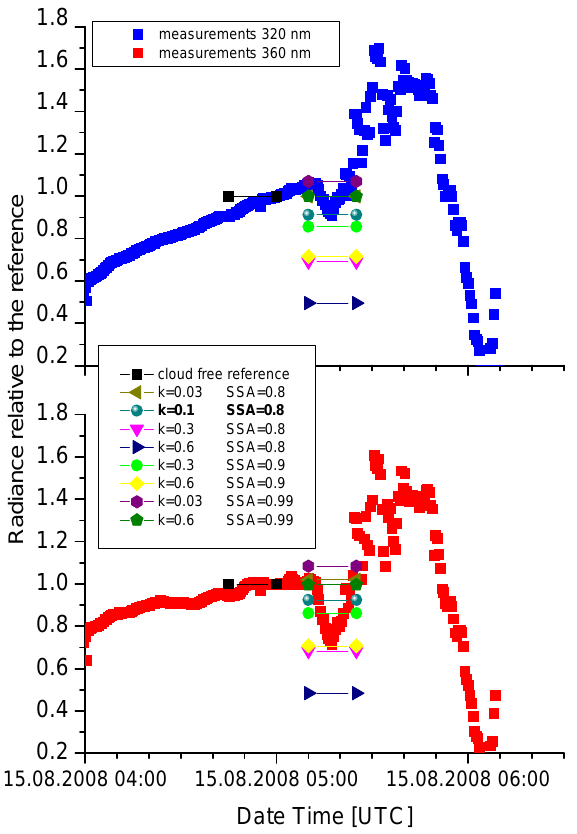
Fig. 14. Simulated and modelled intensity ratios for − 10 ◦ telescope and the 320 and 360nm range. Similar comparisons were made for the − 10 ◦ telescope as well as for the dense cloud. In total the best agreement was observed if the aerosol extinction is assumed to be 0.1 and the SSA = 0.8. The clouds below the aerosol layer were included according to the results of Sect.